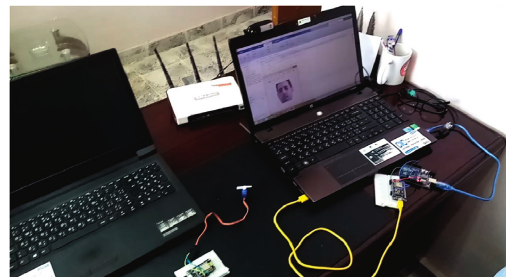
Figure 6: Communication between the HTTP client (right PC) and HTTP server (left PC); the nonsmiling state with the horizontal motor